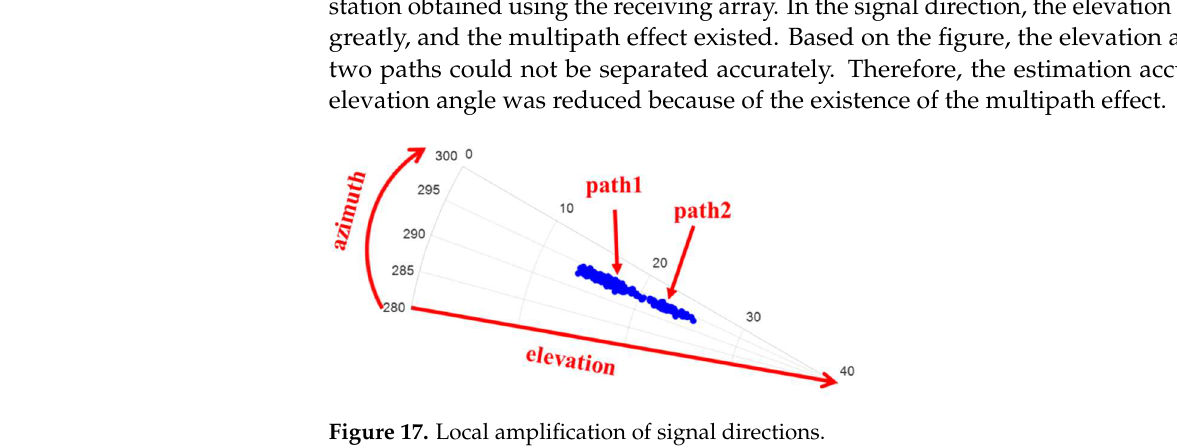
Figure 19. Statistical results for the elevation angle. 6. Conclusions